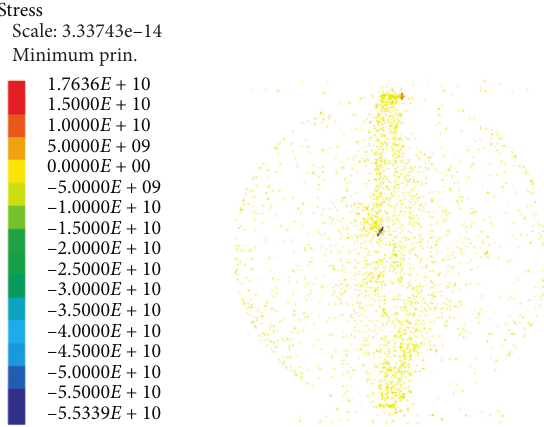
Figure 6: Loaded cloud of homogeneous